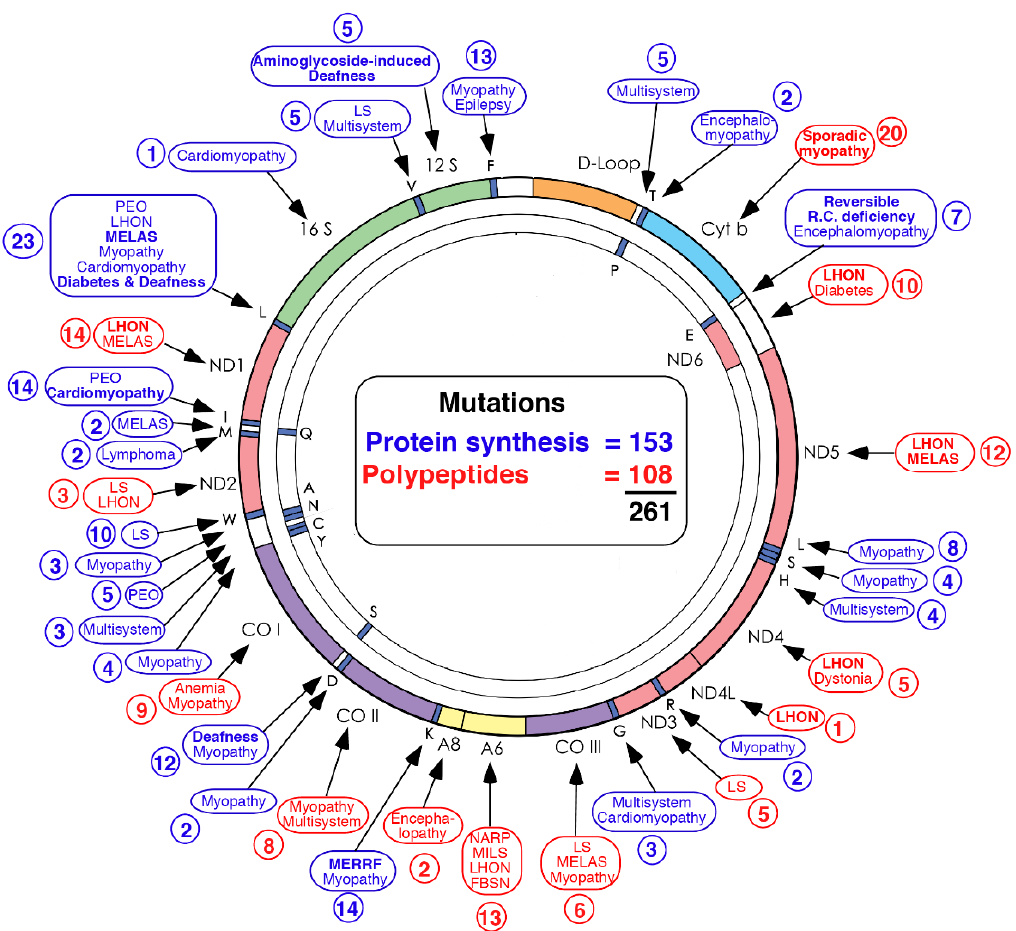
Figure 1. Morbidity map of mitochondrial DNA. Disorders caused by mutations in protein-coding genes are shown in red. Disorders caused by mutations in genes controlling protein synthesis are shown in blue.